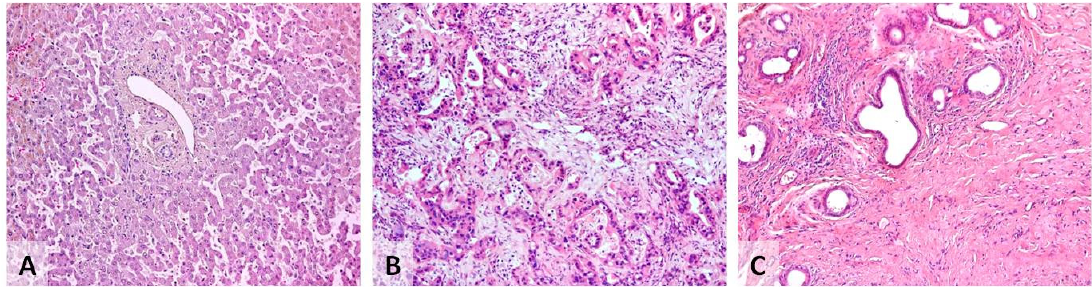
Figure 1. Hematoxylin and eosin (H and E) staining. Representative pictures of human liver biopsies from peritumoral hepatic tissue ( A ); intrahepatic CCA (iCCA) ( B ); and extrahepatic bile duct carcinoma (eBDC) ( C ). They show the dramatic morphological changes in the histological aspect from a non-malignant tissue, with the physiologic hepatic cords, regular sinusoid and portal space containing the typical branches of the hepatic artery, portal vein and biliary ducts ( A ); and the tumoral tissues, where the hyperplastic cellular growth is matched with a large deposition of connective tissue and inflammatory infiltrate ( B – C ). Original Magnification (OM) 10×.